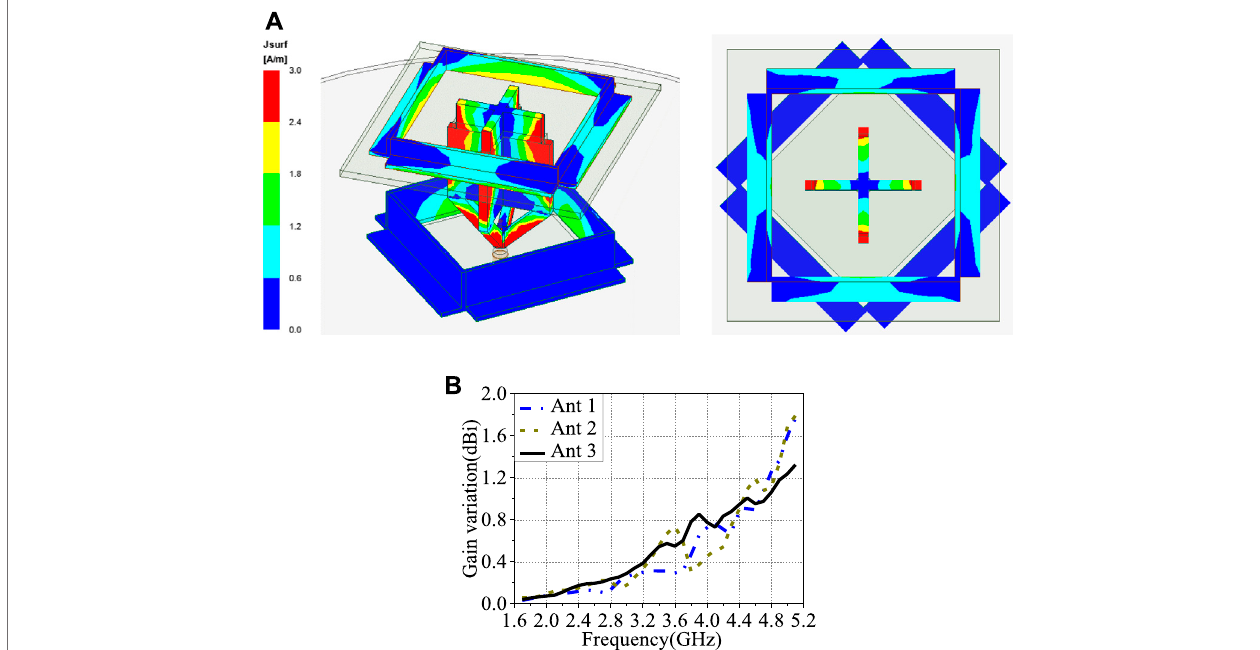
FIGURE 7 | (A) Current distribution of proposed antenna at 5.1 GHz, and (B) gain variations of Ant 1, Ant 2, and Ant 3.